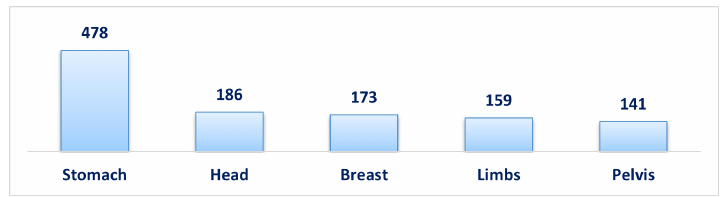
Figure 11. Frequency of damage to various anatomical areas